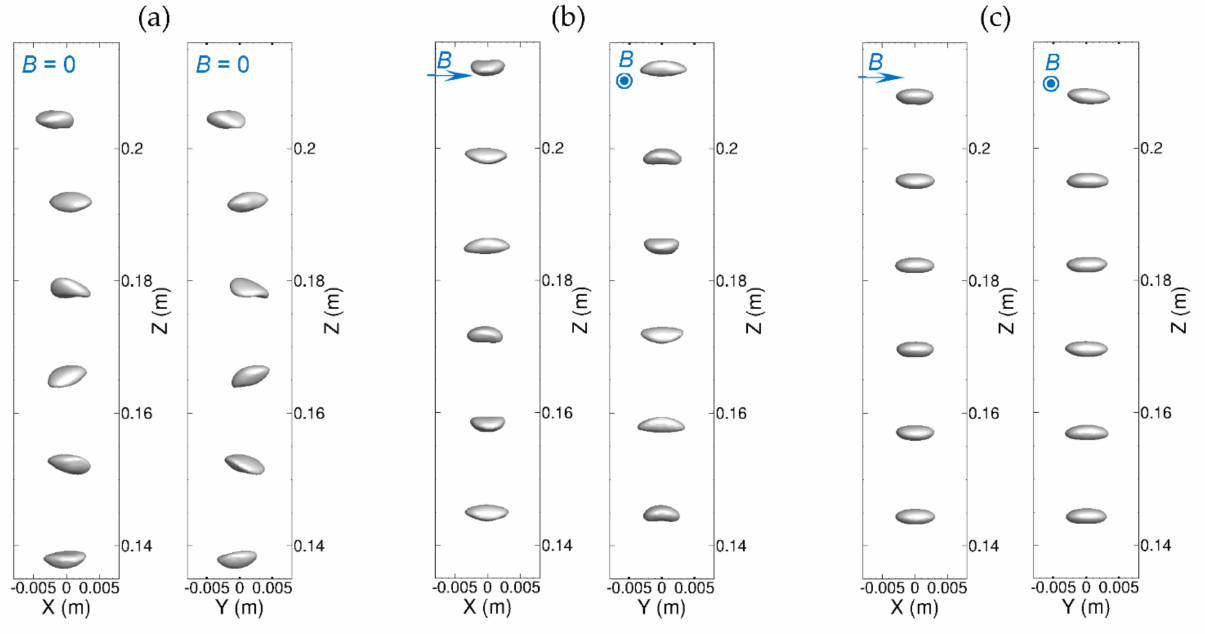
Figure 15. Instantaneous bubble shapes for ( a ) B 0 = 0 T, ( b ) B 0 = 0.14 T and ( c ) B 0 = 0.28 T at time intervals of 0.05 s. The trajectory for B 0 = 0 is not strictly vertical. The bubble shapes for B 0 = 0.14 T and 0.28 T change but remain laterally symmetric in the X–Z and Y–Z